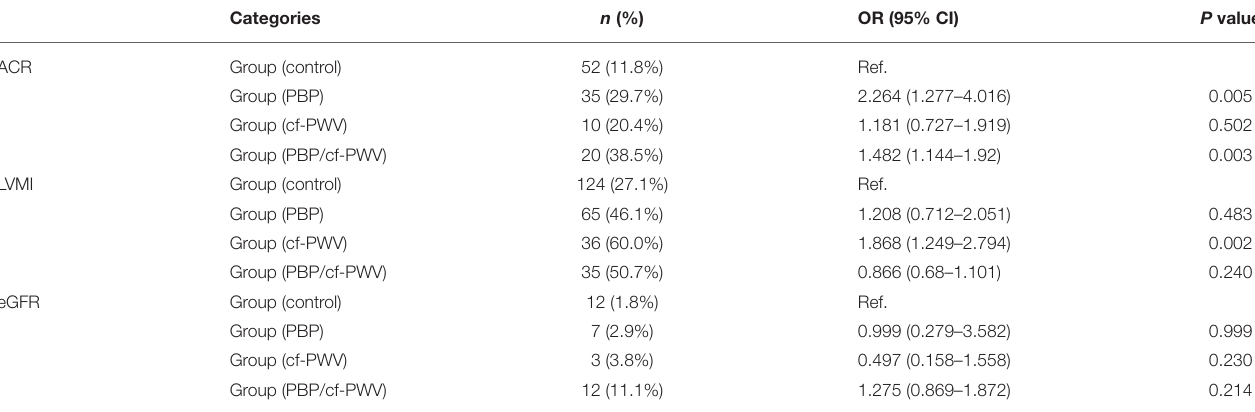
TABLE 4 | Multiple factor binary logistic regression analysis of target organ damage in four